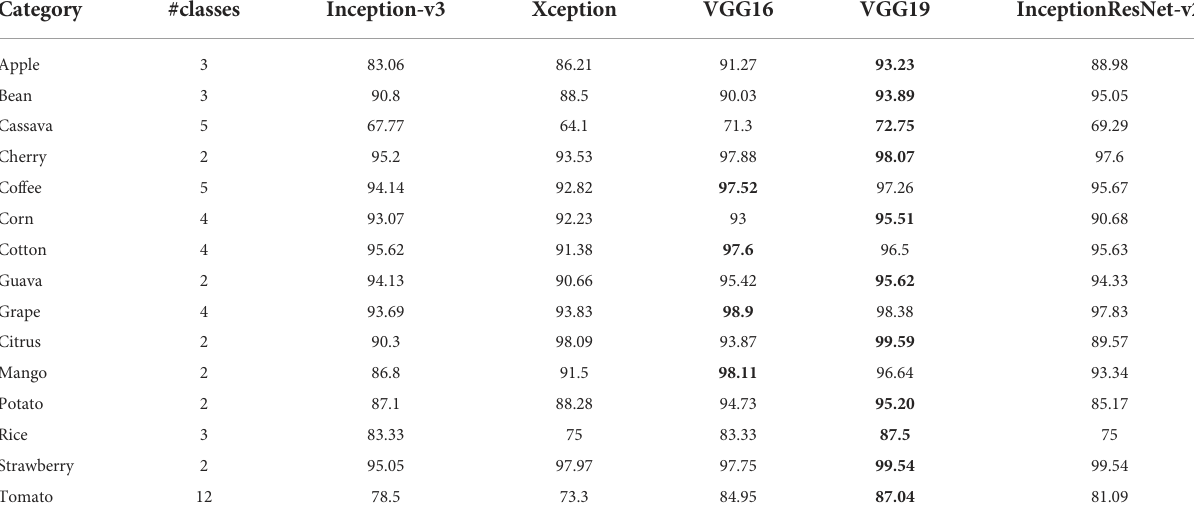
Soybean Bold values, highest accuracy/f1-score. TABLE 9 Macro average test accuracies for some species used in plant diseases category on test set. Category